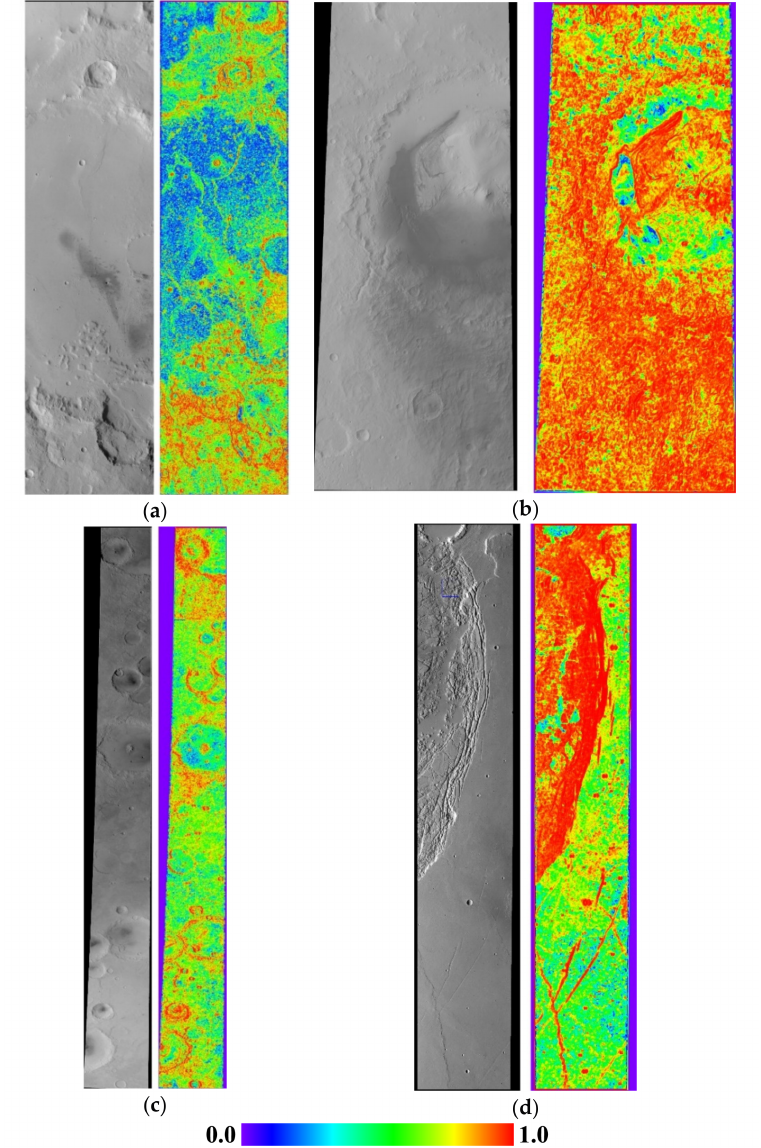
Figure 12. Image matching cost maps calculated using normalized cross-correlation (NCC): ( a ) Orbit 4165; ( b ) Orbit 5273; ( c ) Orbit 4235; and ( d ) Orbit